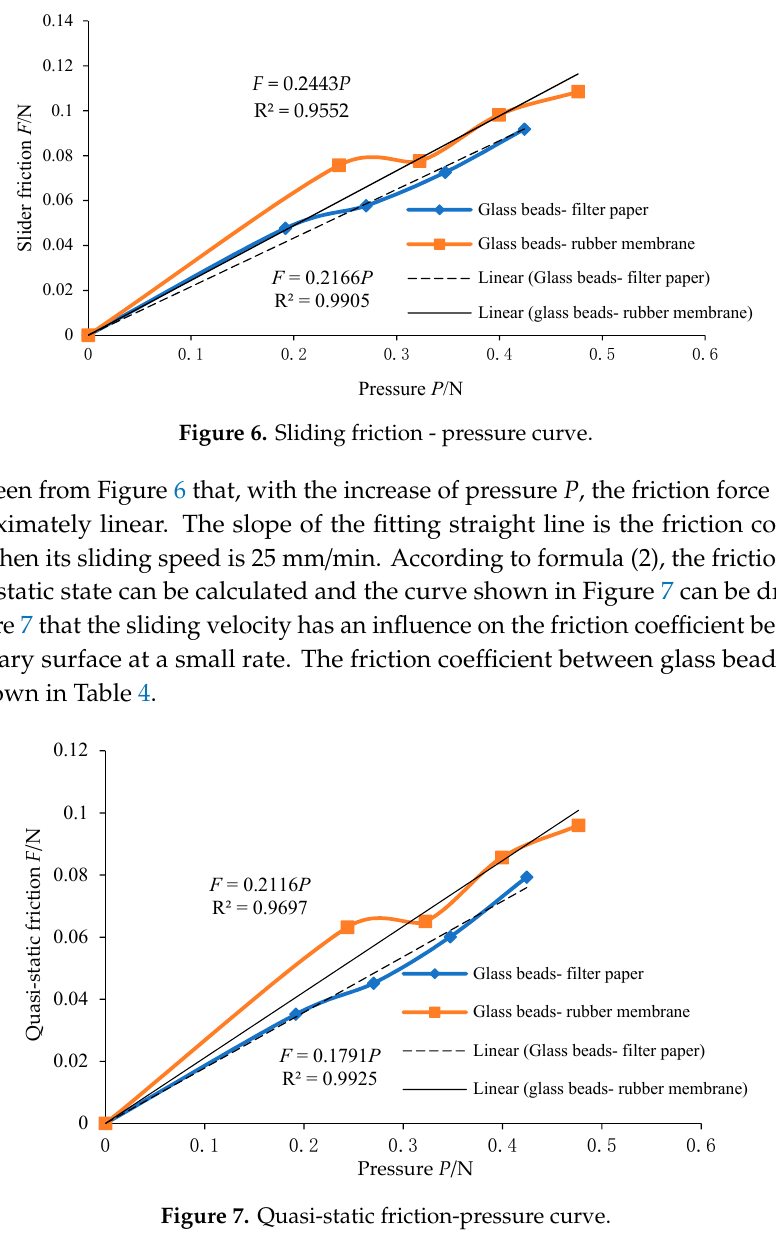
Figure 7. Quasi-static friction-pressure curve. Table 4. Friction coe ffi cients between glass beads and di ff erent